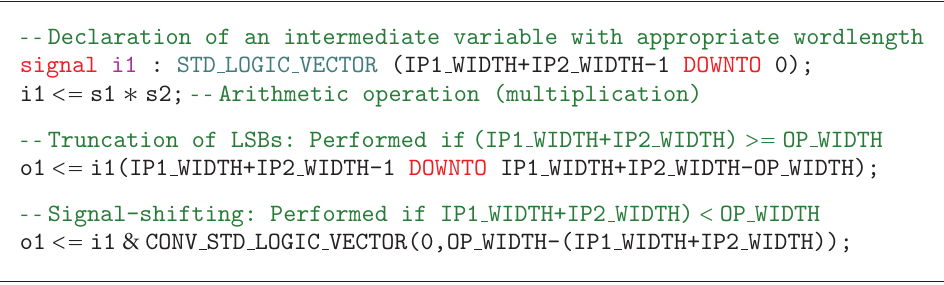
Figure 2: Parameterized architectural design: (a) declaration of a parameterized entity; (b) an example instantiation of a vendor-supplied IP-core; (c) usage of parameterized internal variables and an example of truncation and signal shifting, performed at the module